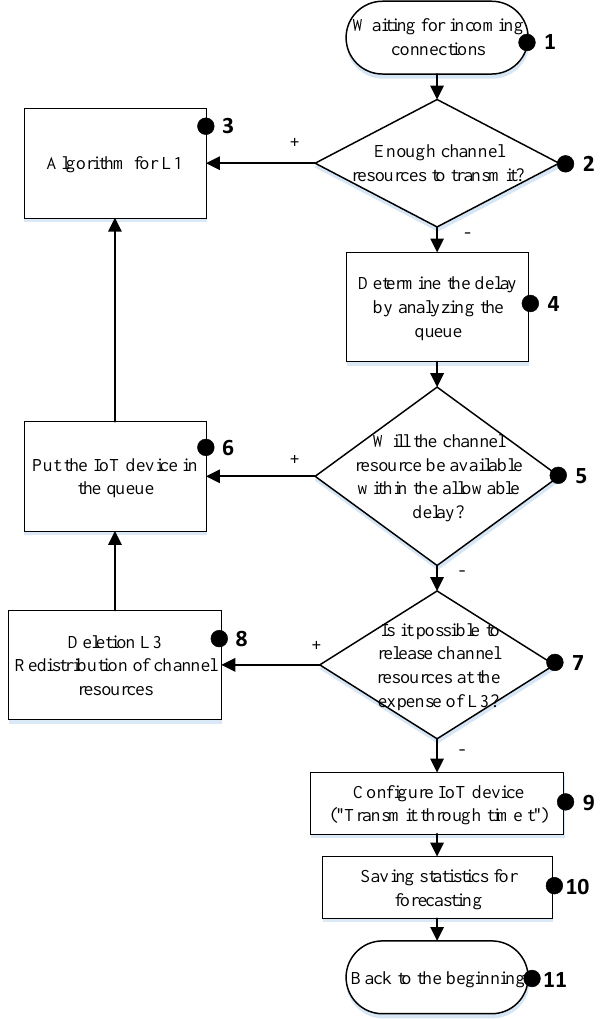
Figure 3. Algorithm for managing the “smart queue” for IoT class L2.